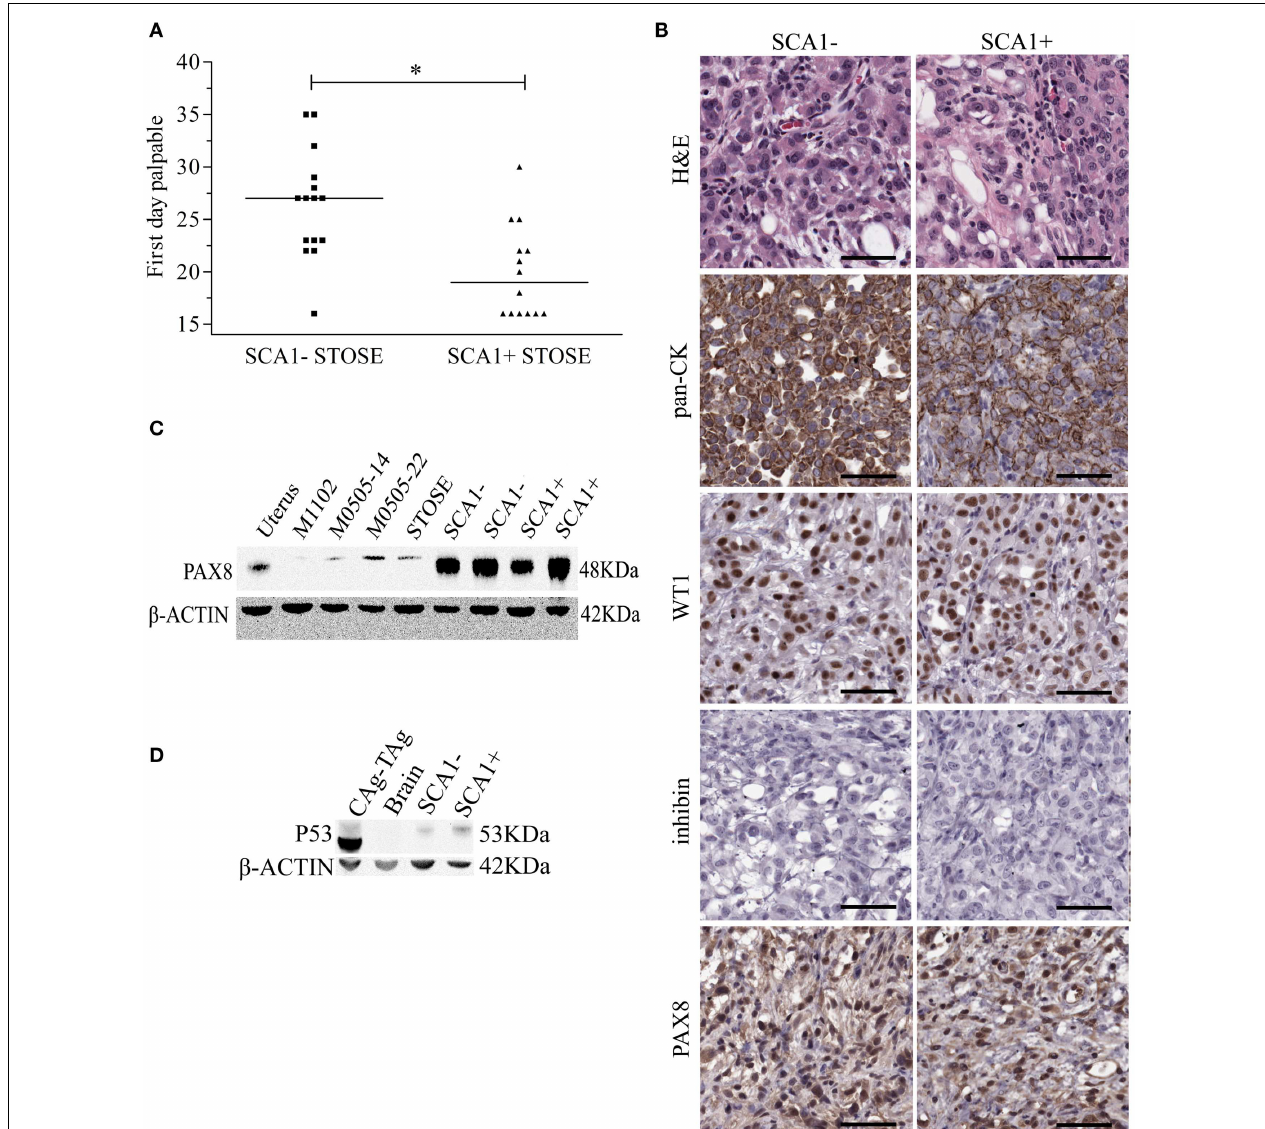
and STOSE-derived SCA1 + and SCA1 − tumors. Lane 1 is uterus from a wild-type FVB/N mouse as a positive control. Lane 2 is the normal M1102 OSE cell line as a negative control. Lanes 3–4 are passage 14 and 22 M0505 cells and lane 5 is STOSE cells. Lanes 6–7 and 8–9 represent tumors derived from SCA1 − and SCA1 + STOSE cells, respectively. β -actin (42kDa) was used as a loading control. (D) P53 (53kDa) expression in STOSE-derived SCA1 + and SCA1 − tumors. Lane 1 is aT-antigen expressing CAg–TAg tumor as a positive control. Lane 2 is brain from a wild-type FVB/N as a negative control. Lane 3–4 represents STOSE-derived SCA1 − and SCA1 + tumors,